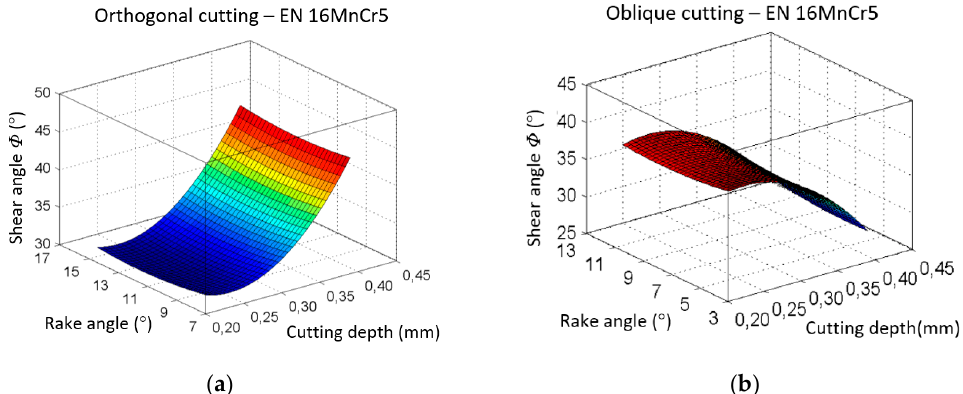
Figure 23. The dependence of shear angle Φ on cutting depth a p and rake angle γ ; ( a ) orthogonal cutting; ( b ) oblique cutting.